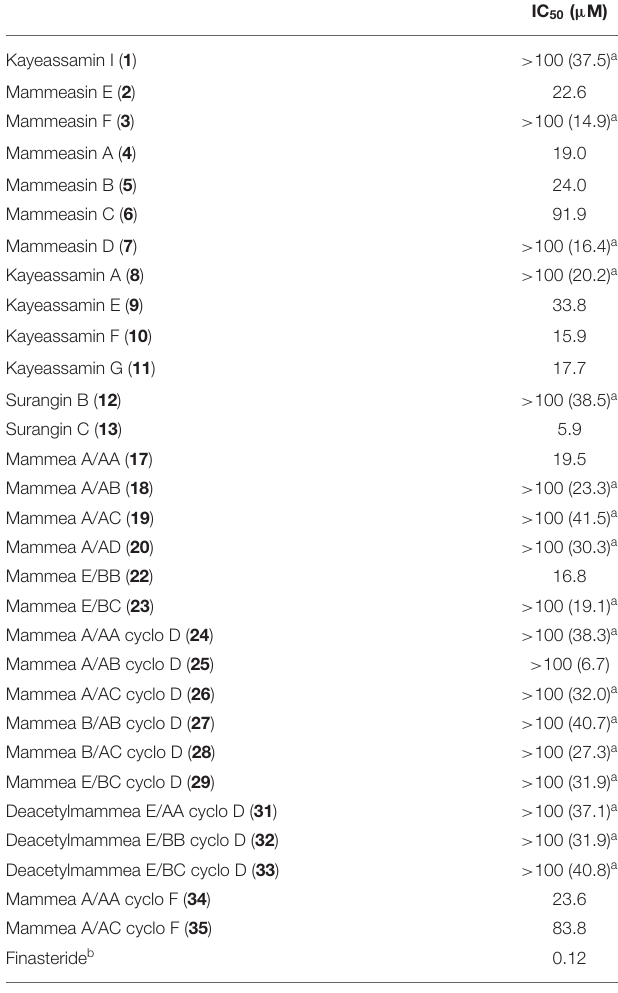
TABLE 3 | IC 50 values of coumarin constituents from M. siamensis on testosterone 5 α